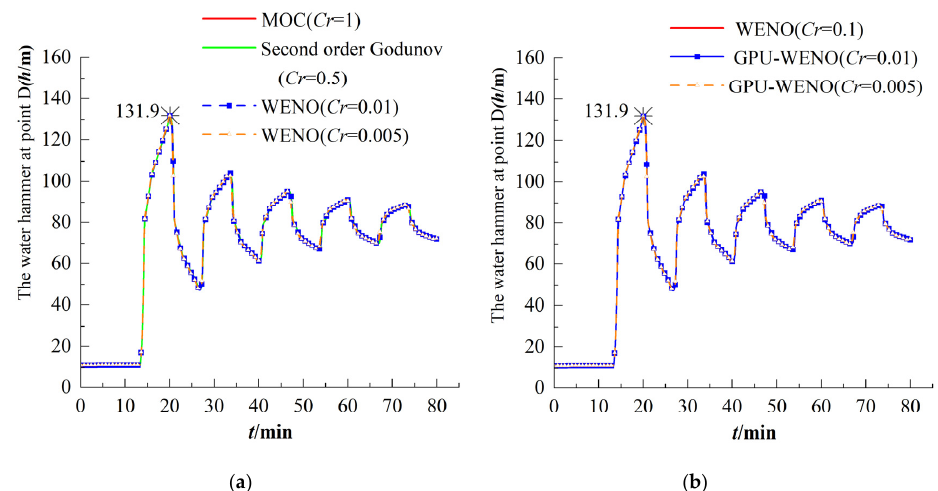
Figure 8. Results of different simulation methods. ( a ) Comparison of accuracy of different methods . ( b ) Precision comparison of GPU acceleration methods.